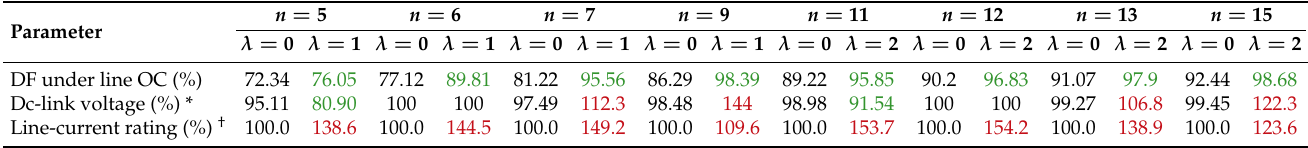
Figure 7. Minimum dc-link voltage (without overmodulation), normalized by twice the magnitude of back-EMF, depending on n and the stator phase connection λ [22]. Table 19. Comparison of recommended stator phase connections λ (cid:54) = 0 and λ = 0 (Section 4.1.3) for different phase numbers under single-line OC, in accordance with Figures 5–7